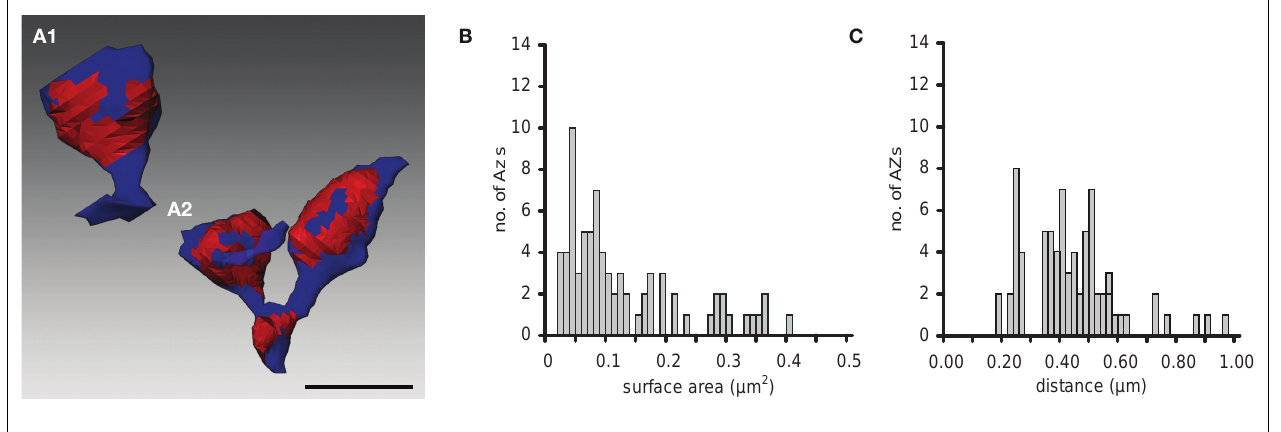
size of individual AZs that formed ring- or patch-like arrangements. Scale bar: 1 µm. (B) Histogram showing the distribution of surface areas of AZs for adult MFBs. (C) Histogram of the distribution of nearest-neighbor distances between centers of gravity of all AZs for adult MFBs (modifi ed from Rollenhagen et al.,